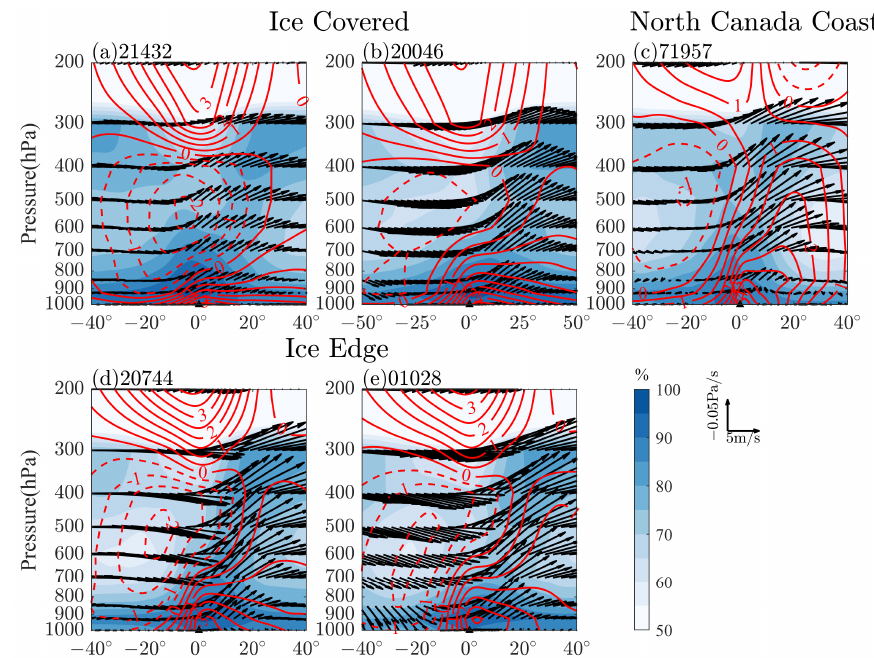
Figure 9. Cyclone-centered composite of longitude-pressure cross-section of relative humidity (blue shaded), air temperature anomaly (red contours), and zonal vertical velocity vector (black vectors) along the center latitude of each of the selected cyclones based on all of the cyclone days in autumns during the period 2001–2017. The x axis ranges from 40 ° west to 40 ° east of the center point. The composited vertical section of the cyclone (Figure 9) shows that the cold core is generally consistent with the descending air and is located at the mid-low troposphere near 600 hPa. Since warm air rises from warm surface to upper levels, the warm core is located at the low troposphere, and the positive temperature anomalies extend upward to near 400 hPa due to warm air rising. However, the centers of positive air temperature anomalies at the upper levels are located at the east of the vertical velocity maximum, for the reason that strong rising leads to an adiabatic cooling in the air. Because relative hu-